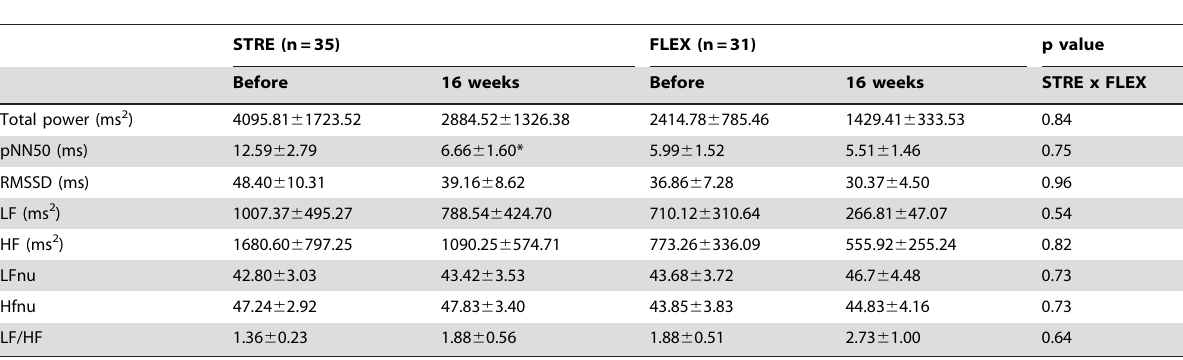
Table 4. Linear analysis of the heart rate variability before and after 16 weeks of training.